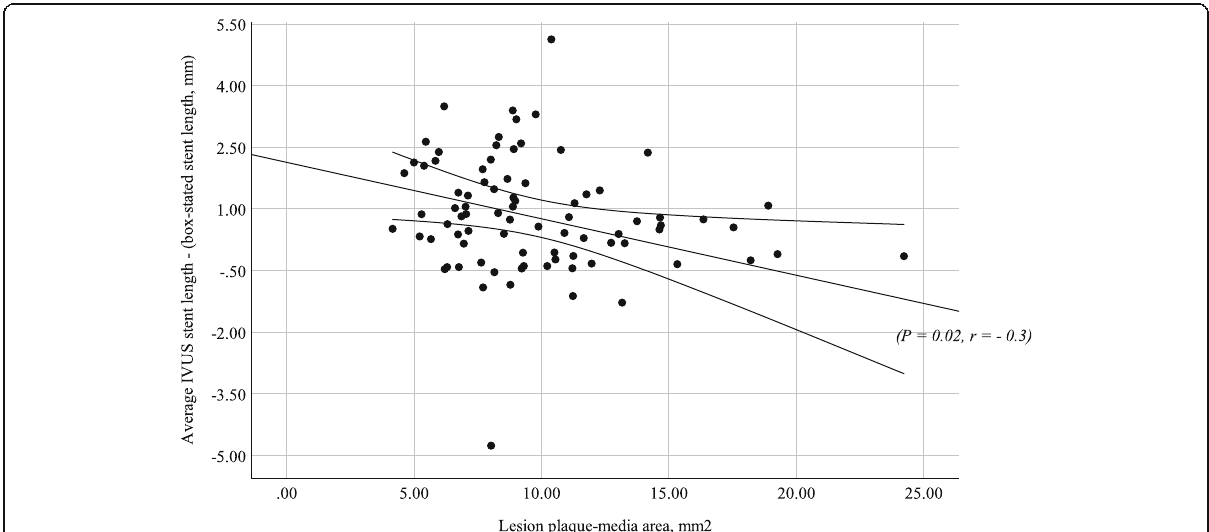
Fig. 3 Correlation between the plaque-media area and difference of stent length. A significant inverse relation between plaque-media area and difference in stent